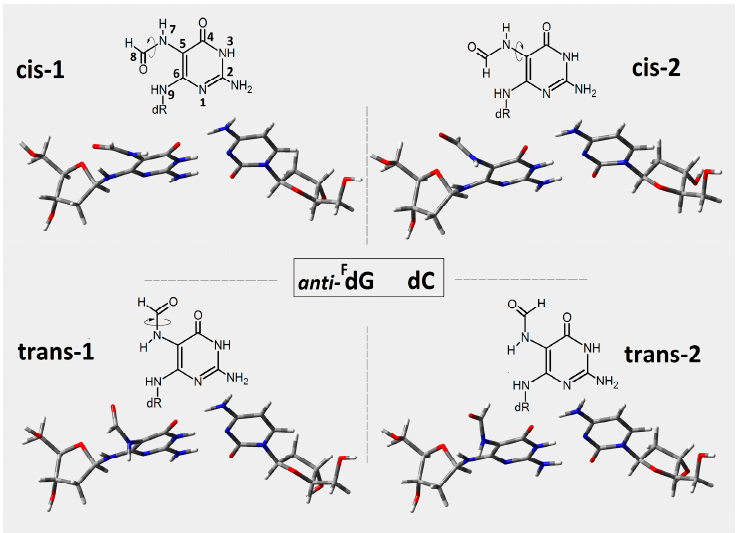
Figure 3. The structure of four anti-FapyG:::dC rotamers isolated from initial d[A1FG2A3OG4A5]*[T1C2T3C4T5] structure optimized on the M06-2x/D95** level of theory in aqueous phase. The cis and trans forms have been assigned according to Carell et al. [18].